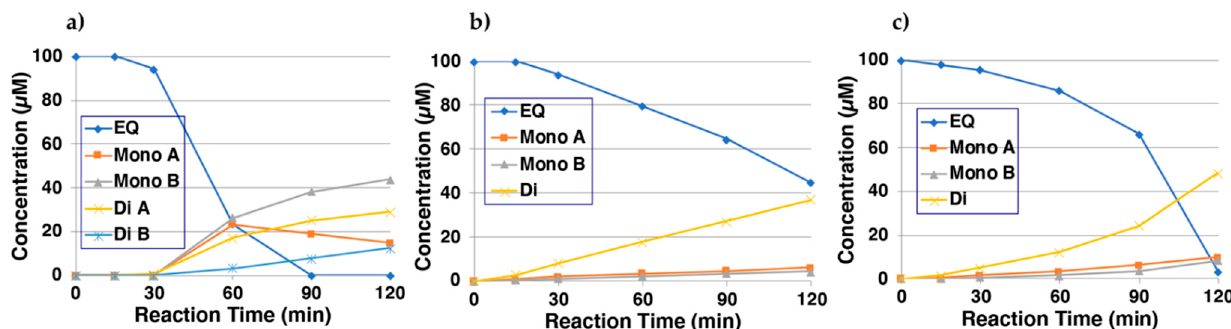
Figure 3. Time course of the tyrosinase-catalyzed oxidation of EQ 1 in the presence of NAC, CySH, or GSH. ( a ) HPLC analysis following the tyrosinase-catalyzed oxidation of EQ 1 in the presence of 3 mol eq. NAC at pH 6.8; ( b ) HPLC analysis following the tyrosinase-catalyzed oxidation of EQ 1 in the presence of 3 mol eq. CySH at pH 6.8; ( c ) HPLC analysis following the tyrosinase-catalyzed oxidation of EQ 1 in the presence of 3 mol eq. GSH at pH 6.8. The reaction was stopped by the addition of HClO 4 . Data were obtained from averages of two independent experiments. Mono-A, mono-B, di-A, and di-B had retention times with decreasing order in each thiol adduct.